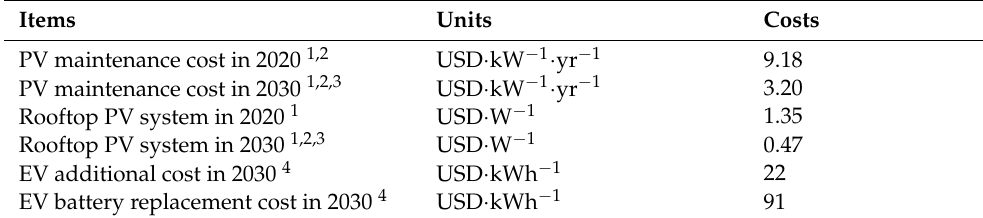
Table 2. System cost estimates in 2020 and 2030 were adapted from [6,14,55,56]. Items